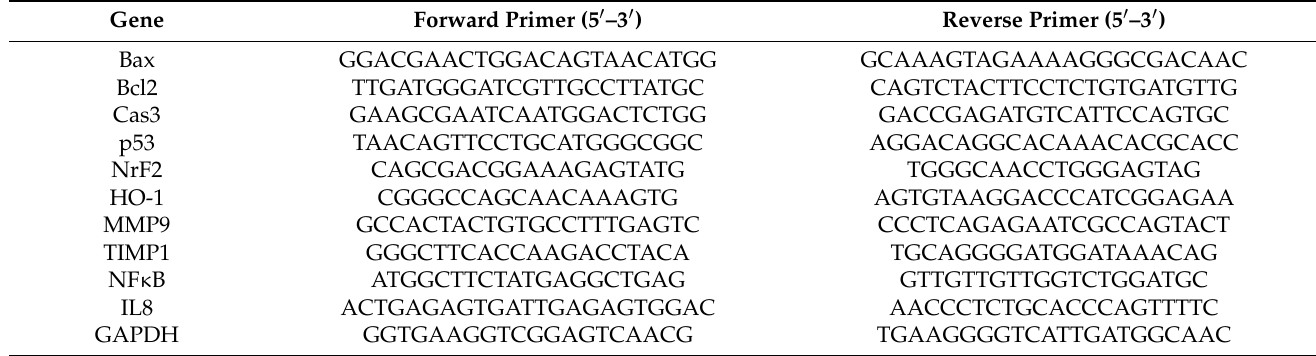
Table 1. Primer sequences used in